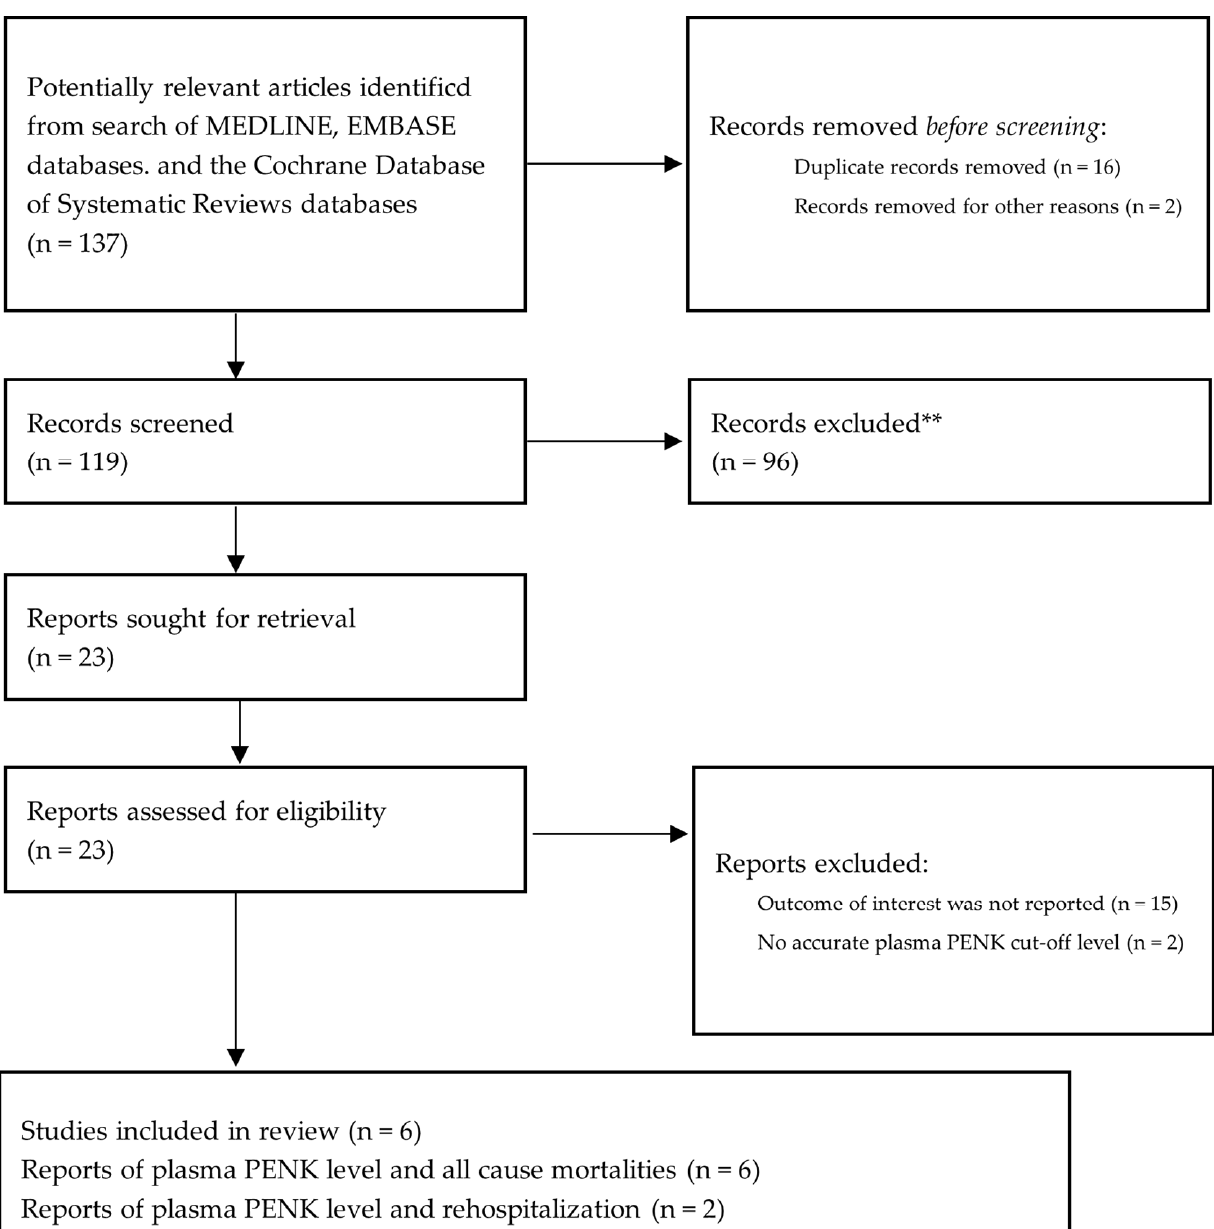
Figure 1. PRISMA flow of our search methodology. ** Records excluded since they were case reports, case series, review articles, in vitro studies, animal studies, or interventional studies. 3.3. Association between a High Plasma PENK Level and Worsening Renal Function Three studies [7,10,11] examined the relationship between elevated plasma PENK levels and deteriorating renal function (Table 1). High plasma PENK levels were associated with deteriorating renal function, with a pooled OR of 1.57 (95% CI, 1.36–1.82, I 2 = 0%; Figure